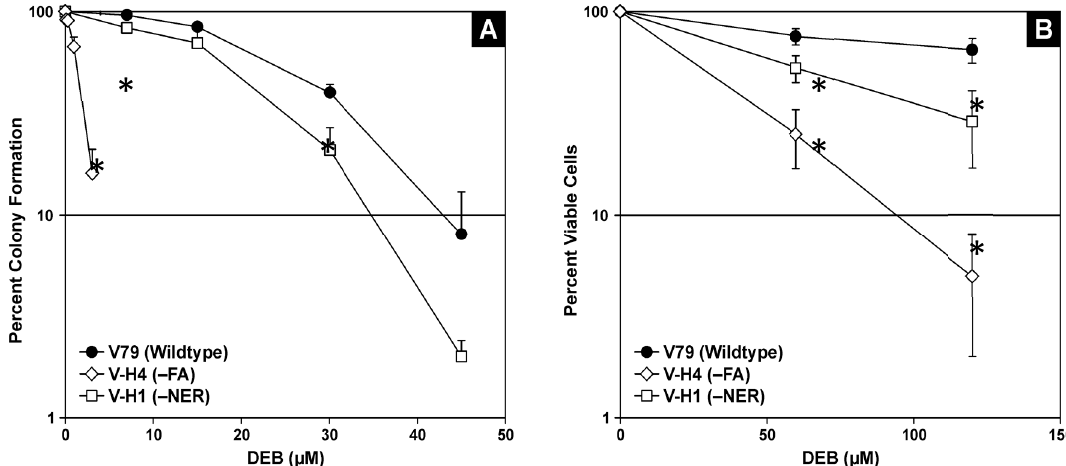
Figure 1 . Effects of exposure to 1,2,3,4-diepoxybutane (DEB) on colony formation and survival of V79 (circles), V-H1 (squares) and V-H4 (diamonds) cells. The influence of exposure to various concentrations of DEB for 3 h on colony forming activity ( A , clonogenic assay), and survival ( B , direct cell counting of trypan blue-excluding cells) was determined as described in the Methods section. Results represent average ± the standard error of the mean (SEM), n = 3 or more. * p < 0.05. Xenobiotic-induced reductions in colony forming ability are generally interpreted to indicate